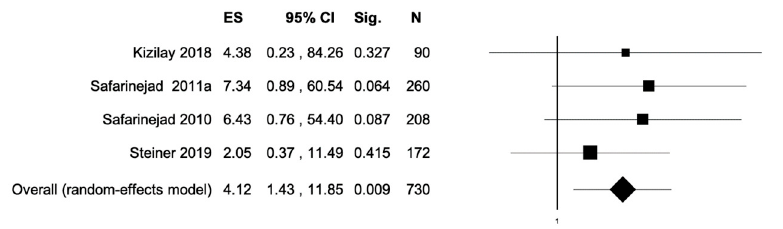
Figure 6. Forest plot showing the OR for dyspepsia. ES, effect size; CI, confidence interval. (I2 = 0.00, p = 0.780).